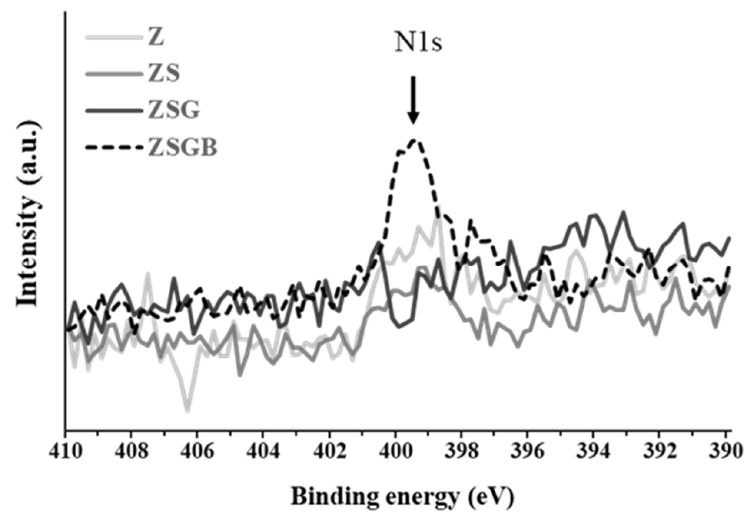
Figure 2. XPS analysis results, in terms of N1s (1s orbital for nitrogen) spectra, of test specimens.